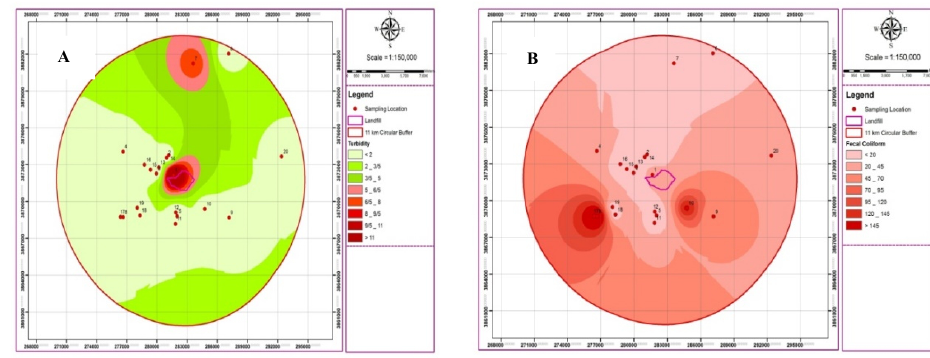
Fig. 2. Spatial Variation of (A) Turbidity, (B) fecal coliforn in groundwater resources in the study area